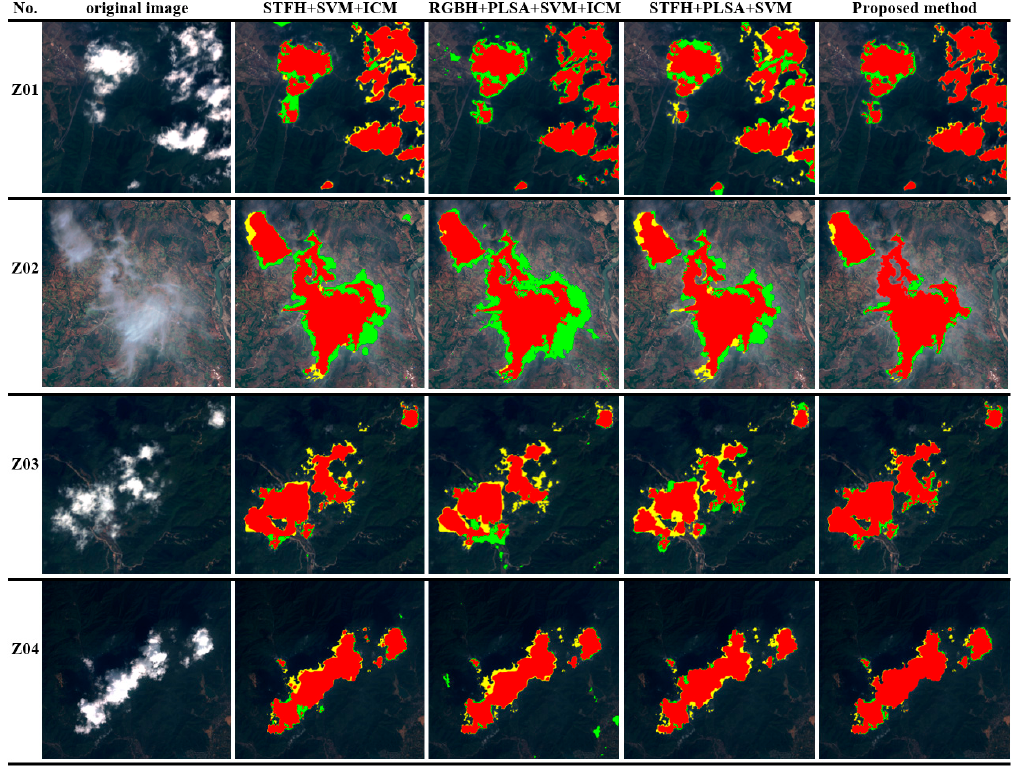
Figure 13. Cloud detection precision analysis of internal feasibility (Red denotes extracted true cloud regions, yellow denotes missed true cloud regions, and green denotes non-cloud regions misjudged as cloud regions).